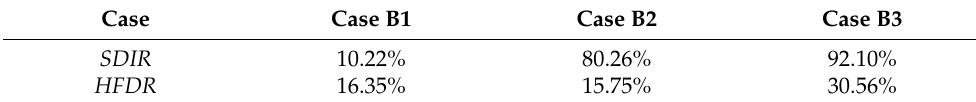
Table 3. Comparison of SDIR and HFDR .